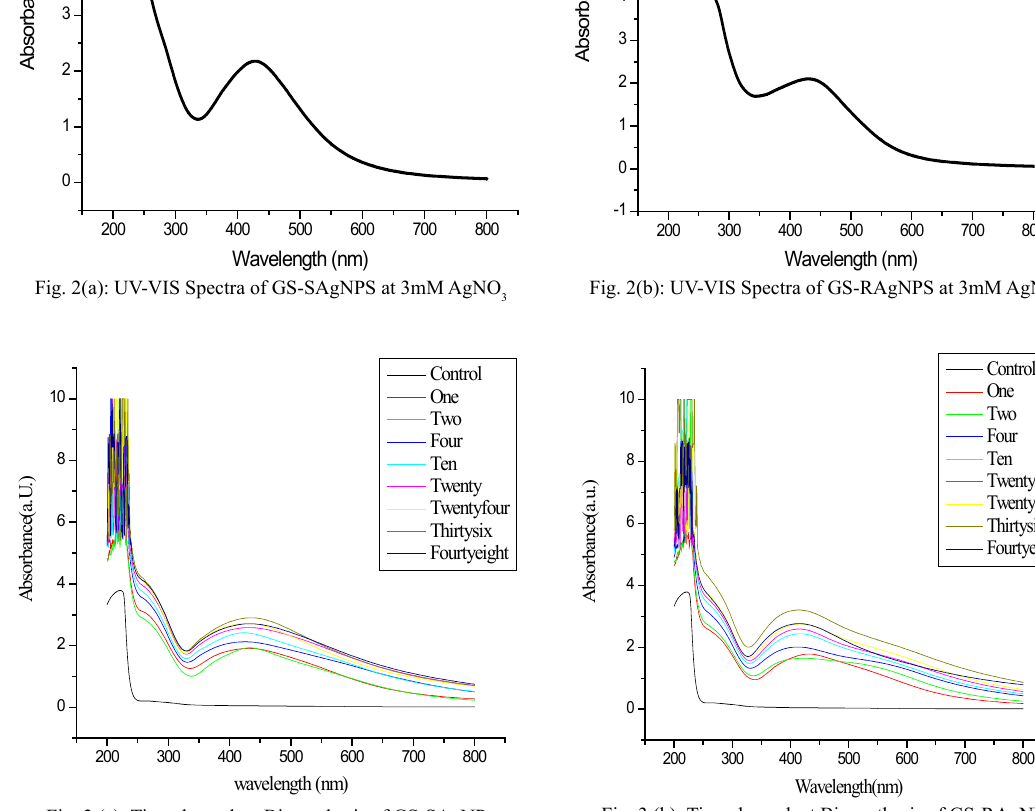
Fig. 3 (a): Time dependent Biosynthesis of GS-SAgNPs Fig. 3 (b): Time dependent Biosynthesis of